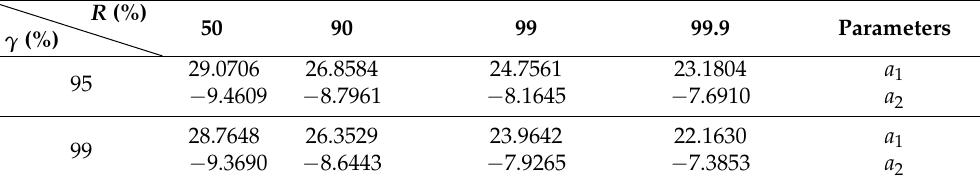
Table 9. Parameters of P–S–N curves at tempering temperature 700 ◦